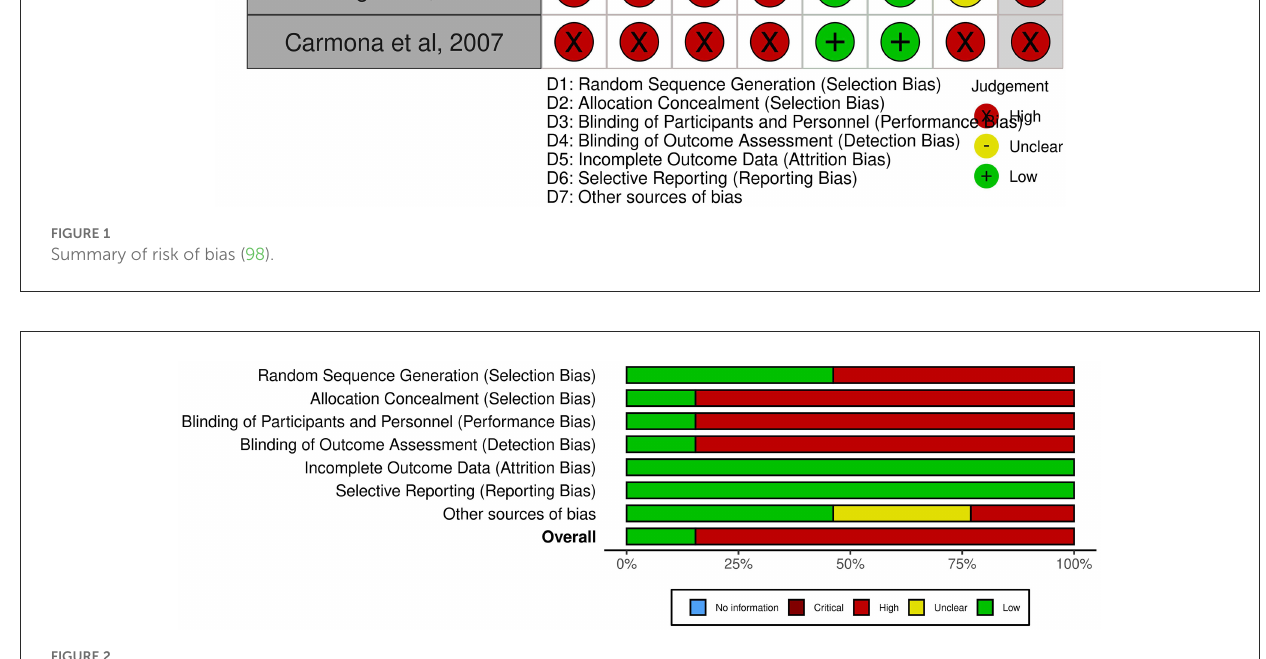
cord-derived MSCs were studied in 2 publications (31, 61). Eight studies describe the use of cell-based autologous blood products The following results were obtained: 8 studies used MSCs as a therapeutic agent for naturally occurring OA (18, 31, 40, 55, 61, 77, 86, 102); 6 studies examined the effect of MSCs after